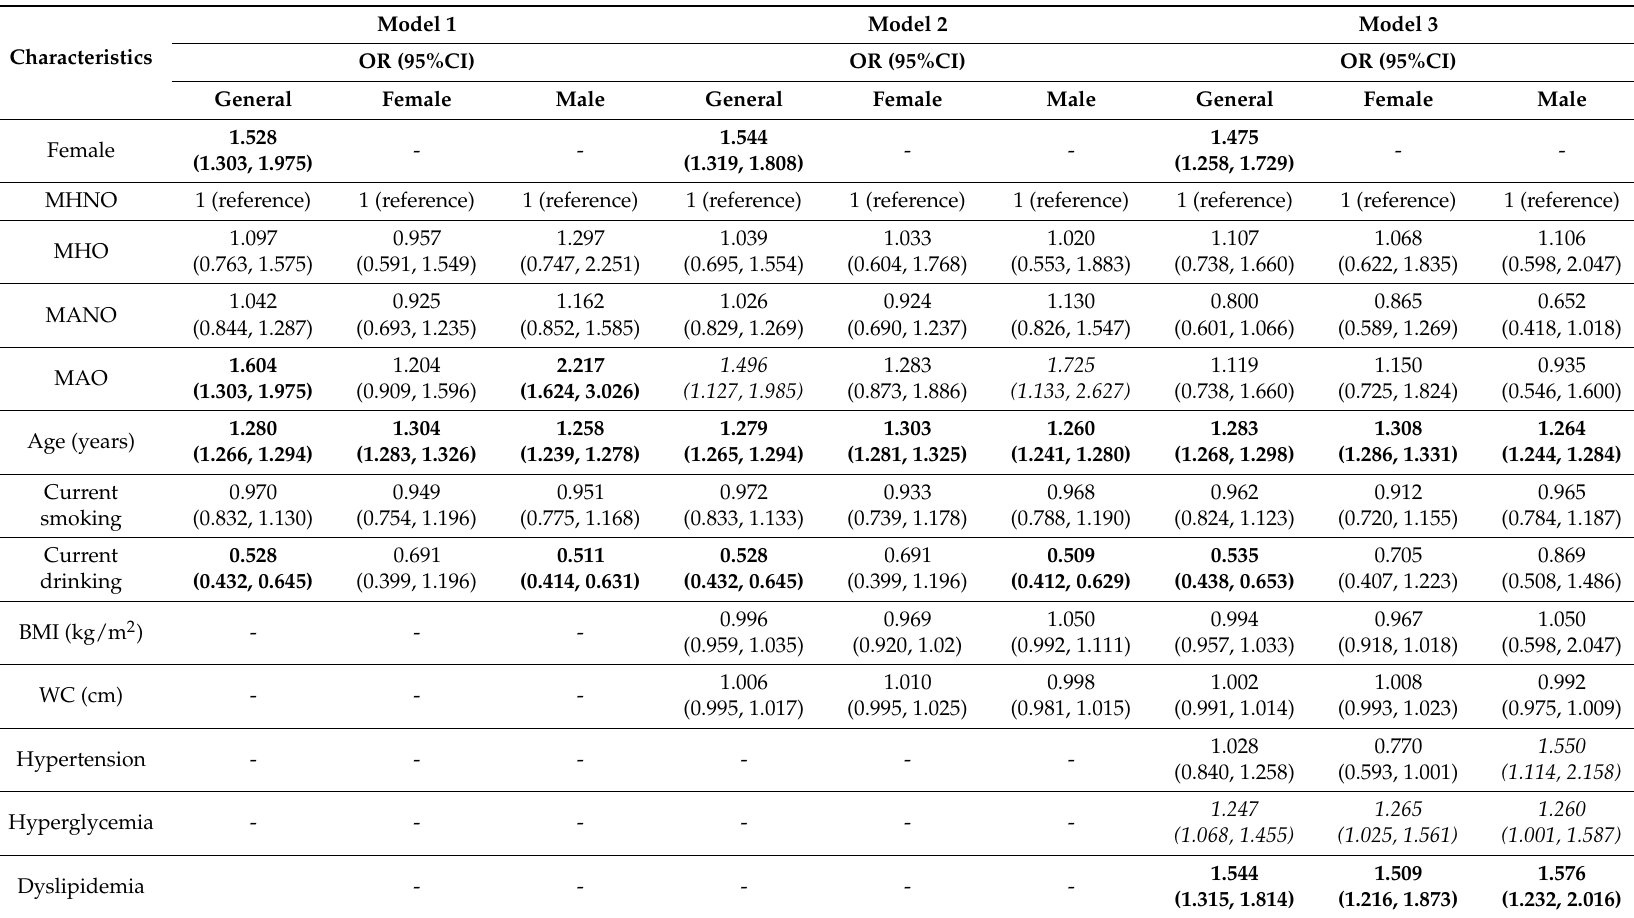
Table 3. Logistic regression analysis of the association between different obese phenotypes and mild reduced eGFR by